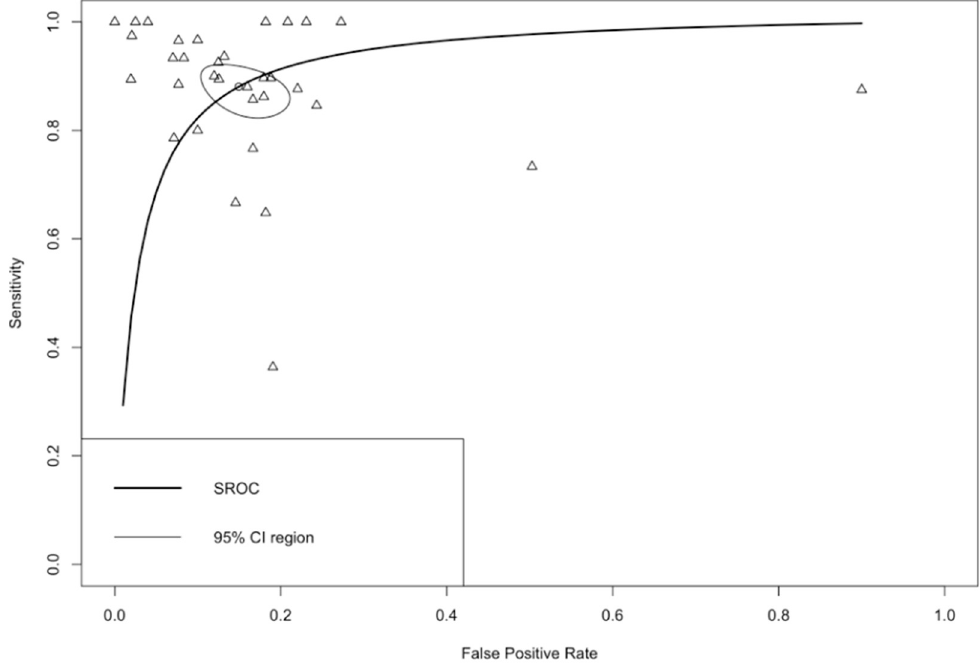
Figure 5. Summary receiver operating characteristic (SROC) curve for diagnostic test accuracy and the respective 95% confidence interval region (95% CI region).